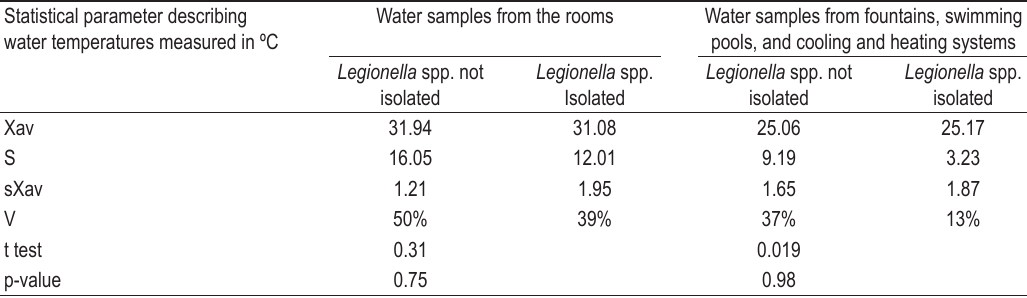
TABLE 1. A comparative review of the value of basic statistical indicators and results of the t ‑test of the measured temperature Statistical parameter describing Water samples from the rooms water temperatures measured in ºC